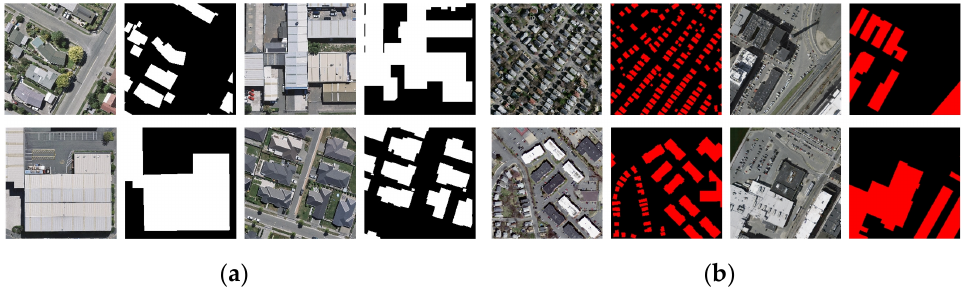
Figure 6. Two aerial datasets image and corresponding building label images: ( a ) the white area in the label map of WHU Building Dataset represents the building; ( b ) the red area in the label map of Massachusetts Building Dataset represents buildings.